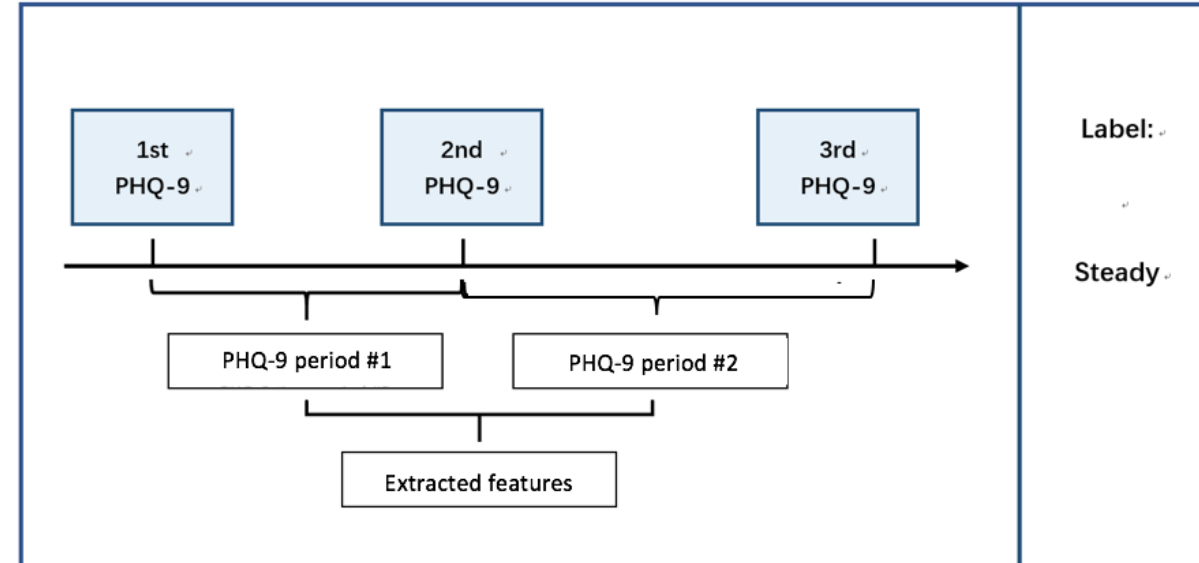
Figure 5. Example of forming a data sample. PHQ-9: Patient Health